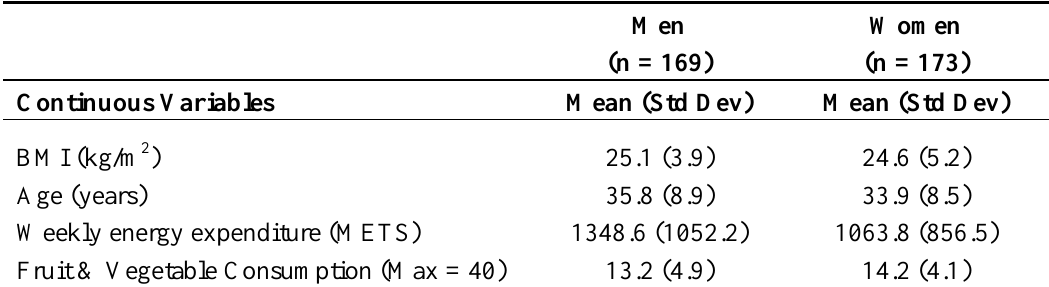
Table 1. Sample characteristics of neighbourhood study participants (n =